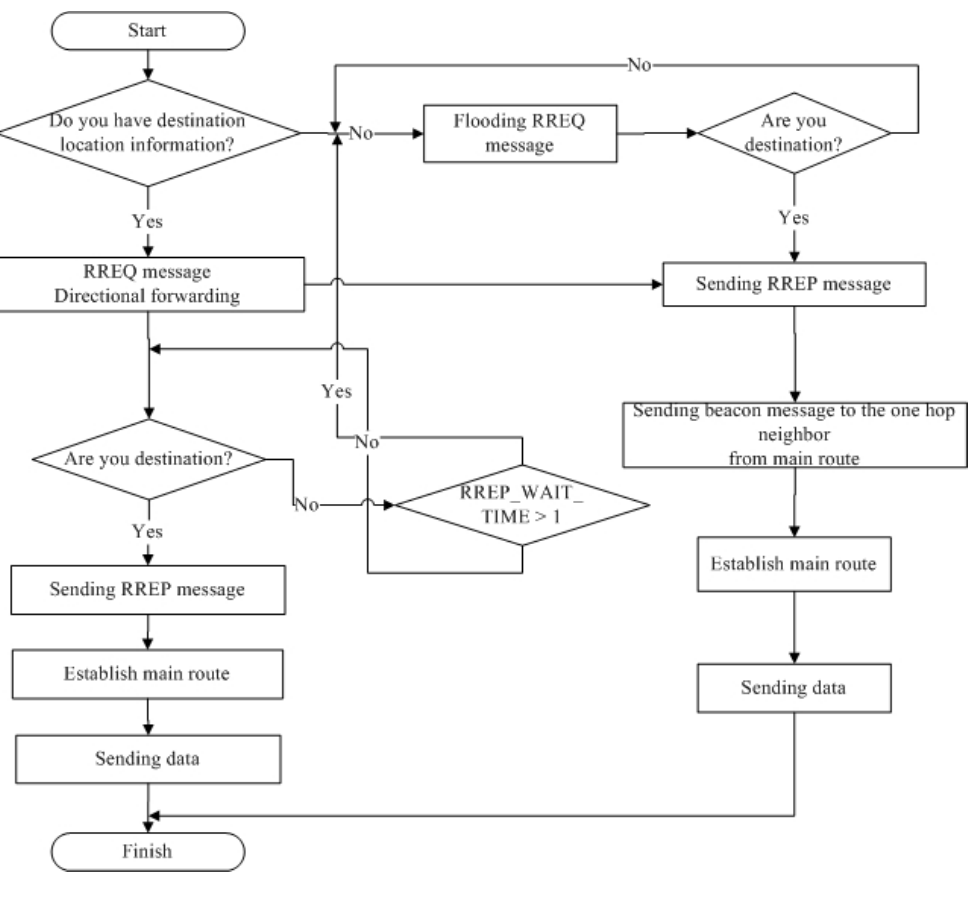
Figure 2 . Basic operational flow